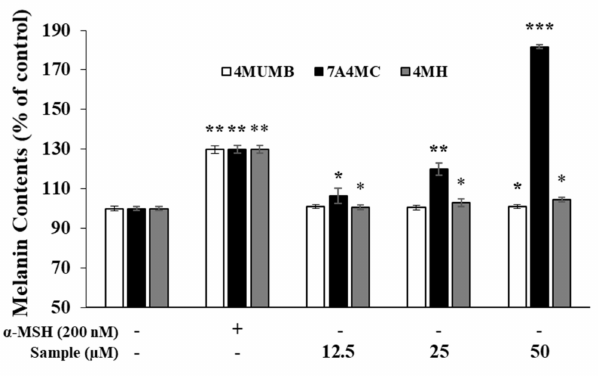
Figure 3. E ff ects of 4MUMB, 7A4MC, and 4MH on melanin production in B16F10 melanoma cells treated with ( + ) or without (-) α -MSH. The cells were treated with 4MUMB, 7A4MC, and 4MH (12.5, 25, and 50 µ M) for 72 h. α -MSH (200 nM) was used as positive control. The data represent the mean ± SD of quadruple experiments. * p < 0.05, ** p < 0.01, *** p <